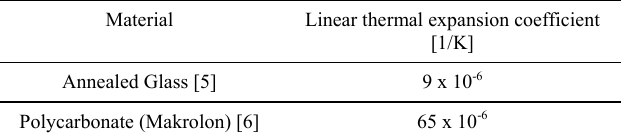
Table 1: Thermal characteristics of glass and polycarbonate.